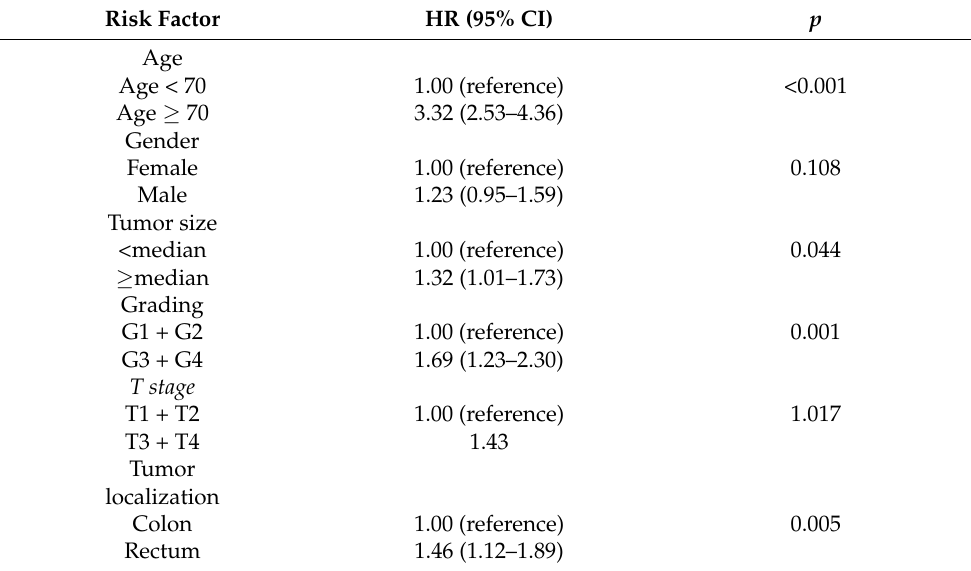
Table 2. Cox regression analysis of the variables considered for the multi-variable adjusted base model.